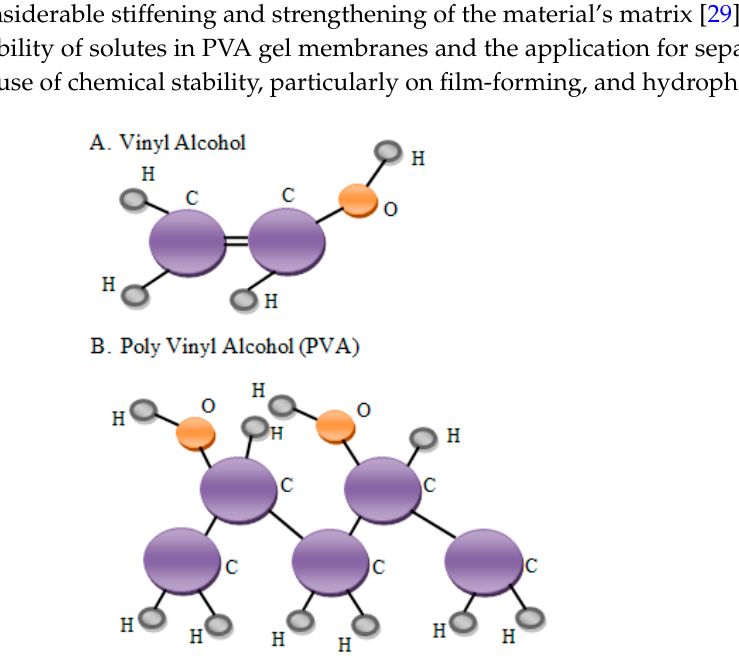
Figure 2. ( a ) The structure of vinyl alcohol; ( b ) PVA is synthesized by the hydrolysis of polyvinyl acetate [26].